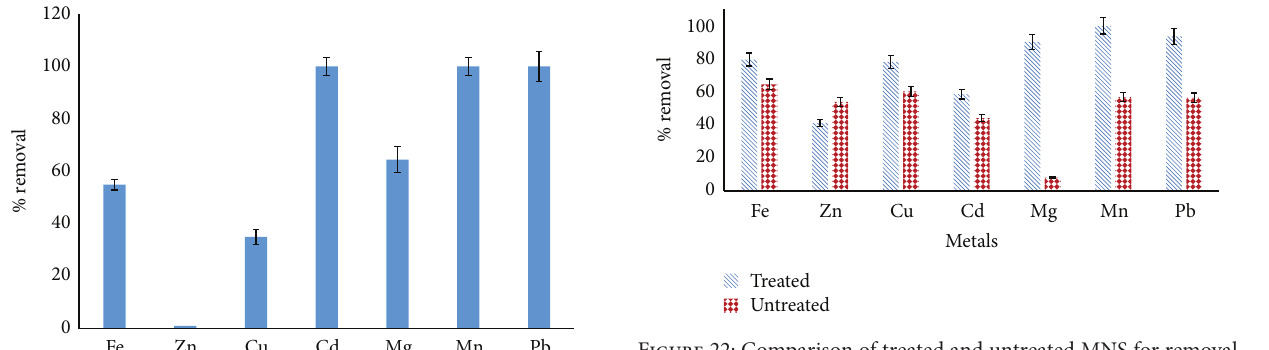
Figure 22: Comparison of treated and untreated MNS for removal of metal from wastewaters at final effluent